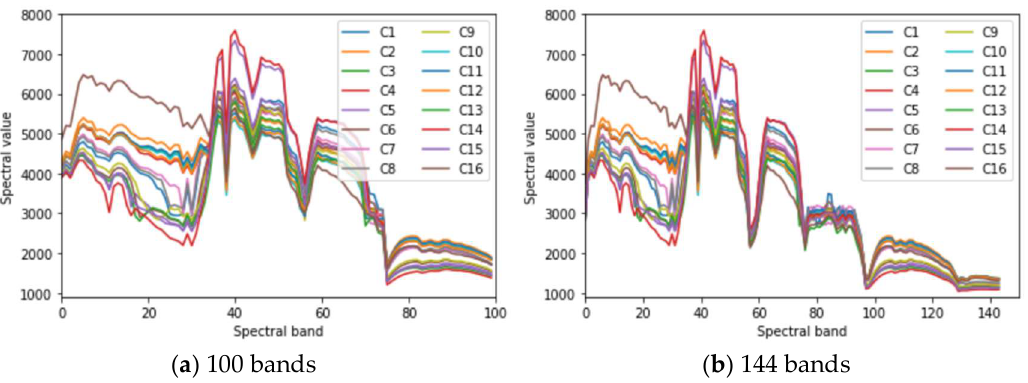
Figure 14. Spectral curves of 100 bands and 144 bands in the Indian Pines dataset. Table 4. Classification results of different number of reserved bands in the Indian Pines dataset.